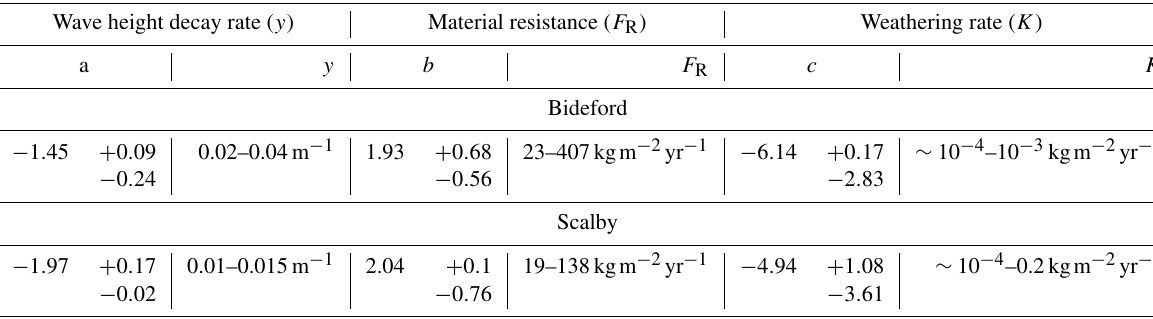
Figure 6. Final results from the 50%–50% weighted multi-objective MCMC calculation for the Bideford study site ( a, b, c, d ; shown in purple) and Scalby study site ( e, f, g, h ; shown in orange). Dark lines show the best-fit results, and the shaded areas show the confidence interval uncertainty range. The 16%–84% confidence interval for each parameter ( F R , K , and y ) was simulated against the median results for the other parameters, and shaded uncertainty regions were constructed from the upper and lower limits of model outputs. Panels (a) for Bideford and (e) for Scalby show the full width of the modelled topographic profile. Panels (b) for Bideford and (f) for Scalby show the first 300m of the modelled platform offshore from the cliff (0m) and compare modelled results to the measured topographic profile (black solid line). Panels (c) for Bideford and (g) for Scalby show the full modelled extent of the 10 Be concentration profile. Panels (d) for Bideford and (h) for Scalby show the first 300m of the modelled 10 Be concentration profile offshore from the cliff (0m) and compare modelled results to the measured and corrected 10 Be concentrations (see Sect. 3.1). Grey boxes (a, c, e, g) correspond to 300m distance offshore (b, d, f, h) . Time stamps for the cliff positions across the 8000-year-duration simulation time were back-calculated and shown against corresponding cliff positions. Table 3. Best-fit parameter results from 50%–50% weighted, multi-objective MCMC